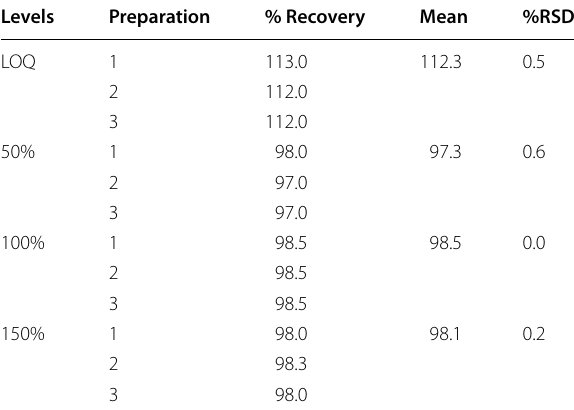
Table 6 Limit of quantification, detection and response factor (LOQ, LOD and RF)